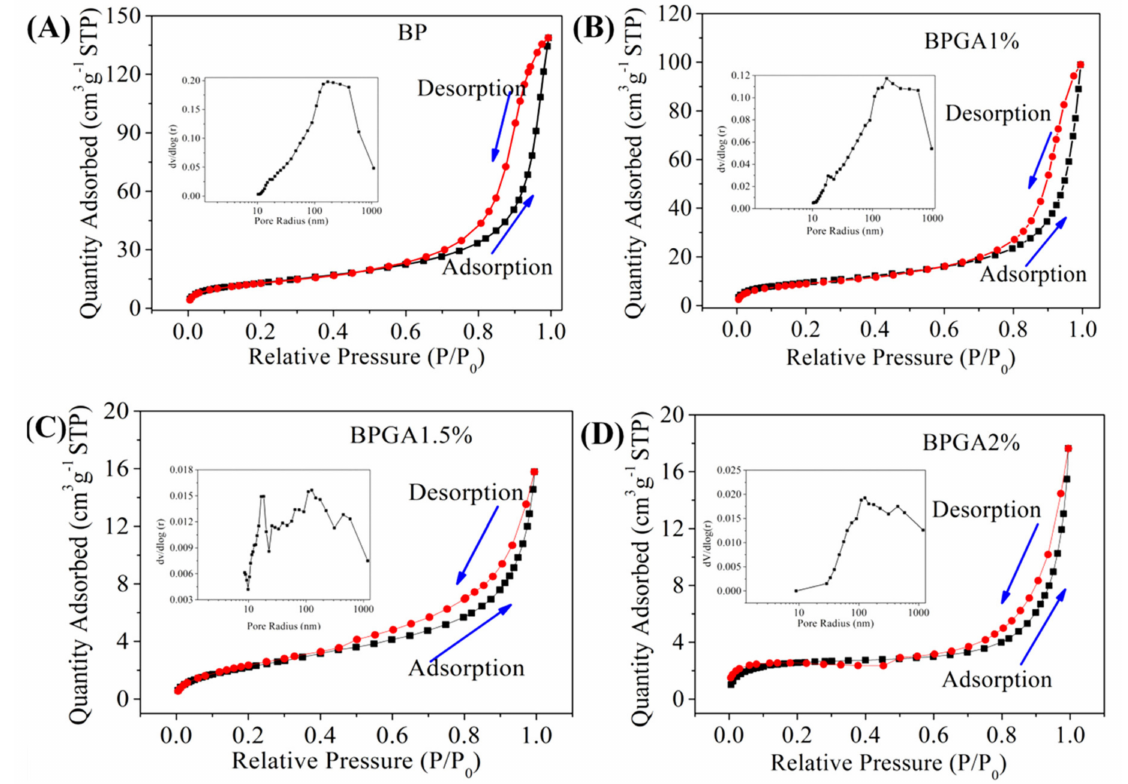
Figure 5. The N 2 adsorption / desorption isotherms of the prepared adsorbent materials: BP, BPGA1%, BPGA1.5% and BPGA2%; the insets indicate the corresponding pore size distributions. ( A ) BP, ( B ) BPGA1%, ( C ) BPGA1.5%, ( D )